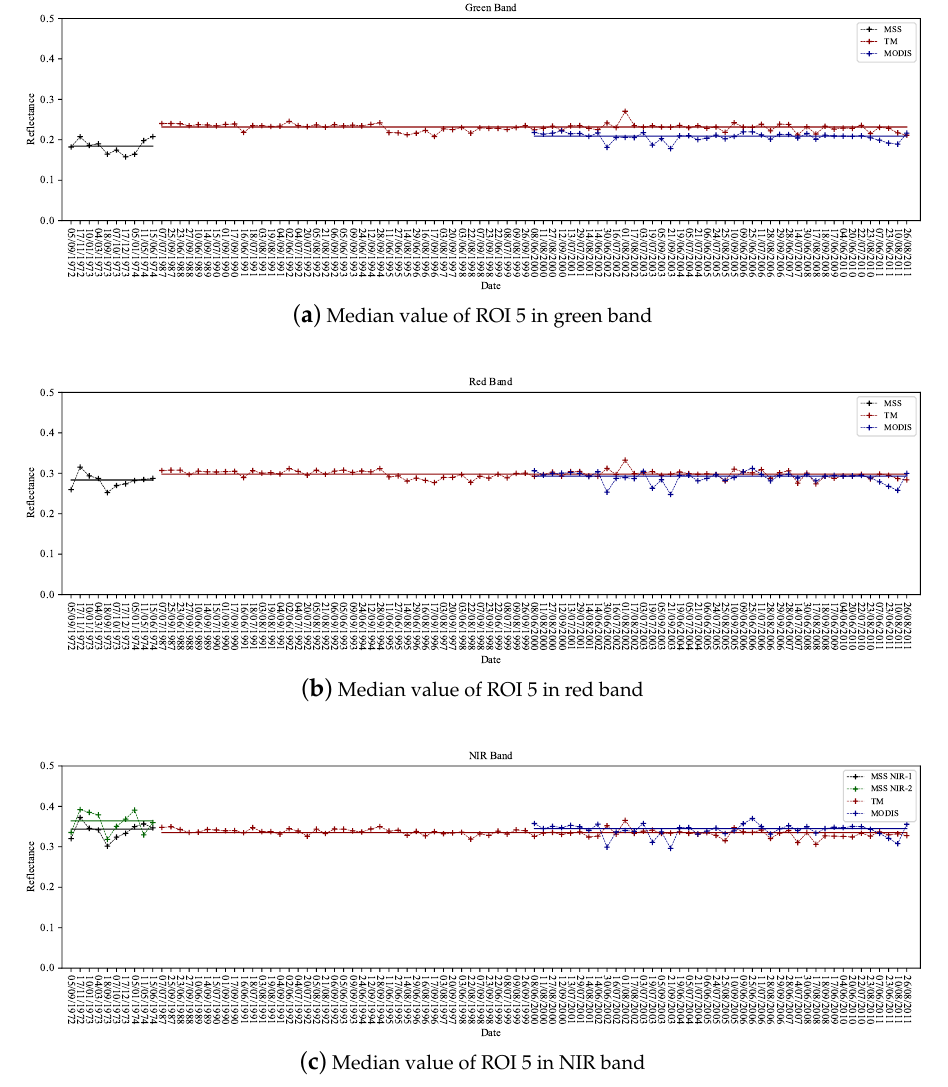
Figure 13. Time series of ROI 5 median value (ROI 5: